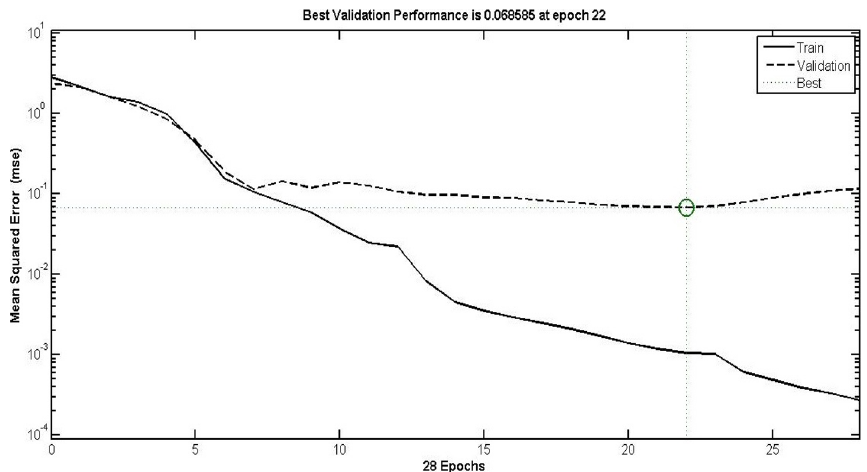
Fig. 7 A record for the errors of training and validation during the training process for the 1st network